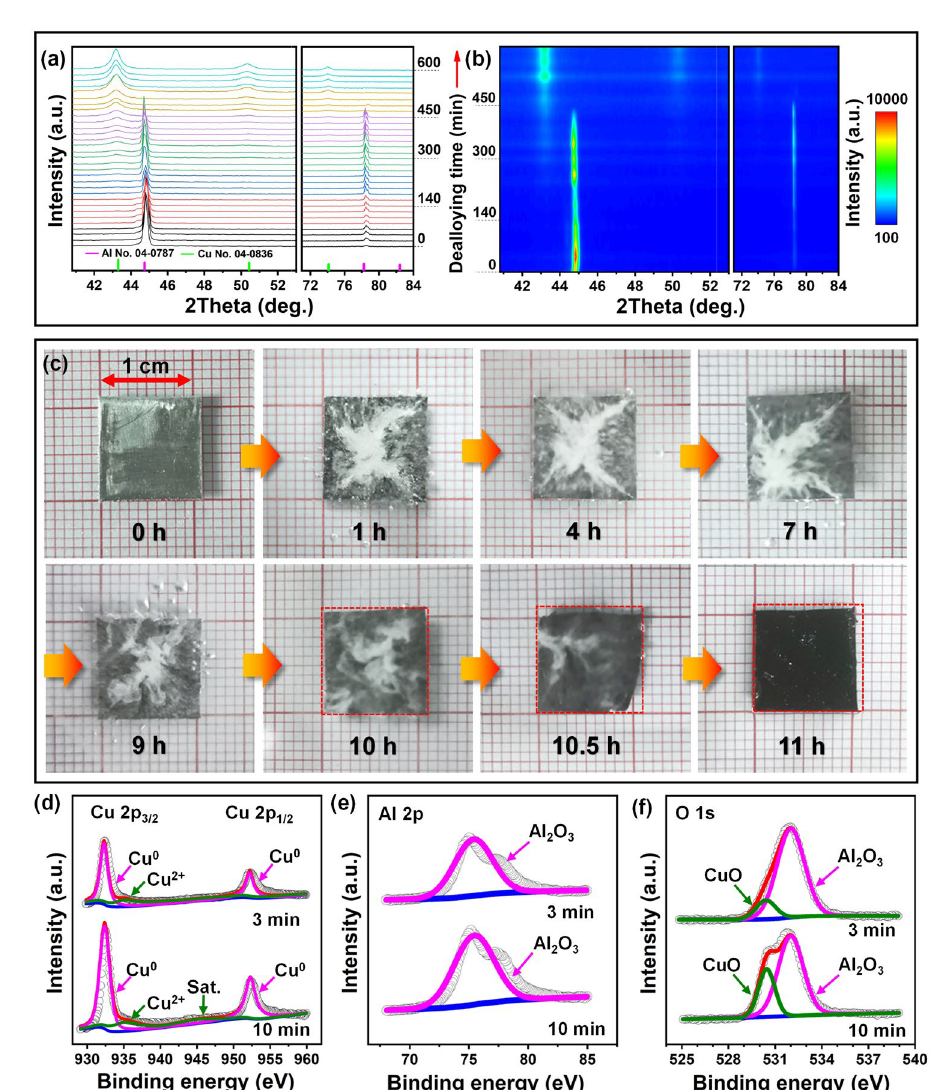
Fig. 3 a In-situ XRD patterns and b corresponding contour plot showing the phase evolution of the Al 98 Cu 2 precursor during dealloying in the 0.5 M NaOH solution. c Macrophotographs of the Al 98 Cu 2 alloy foil dealloyed for different durations. The red dashed boxes represent the size of the pristine precursor. XPS spectra of d Cu 2 p , e Al 2 p and f O 1 s of the Al 98 Cu 2 foils dealloyed for 3 and 10